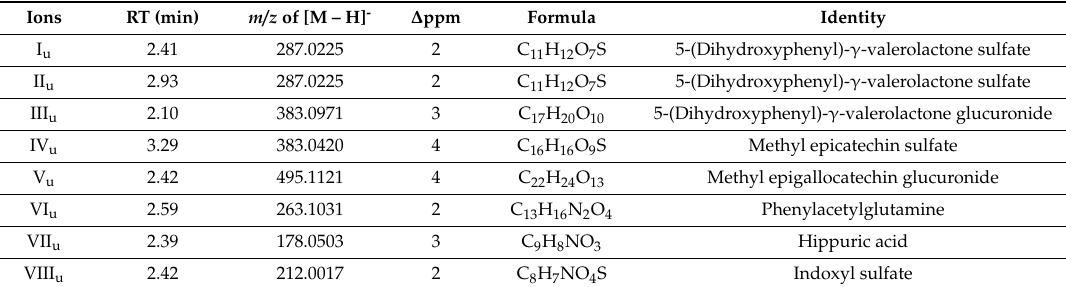
5-(Dihydroxyphenyl)- γ -valerolactone